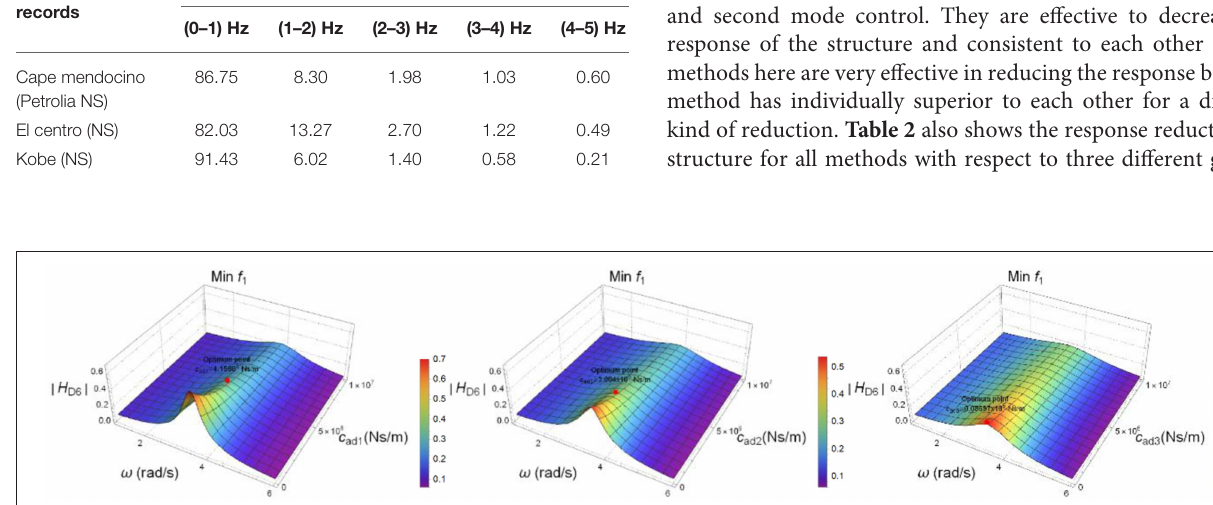
FIGURE 7 | 3D plots of the absolute value of transfer function